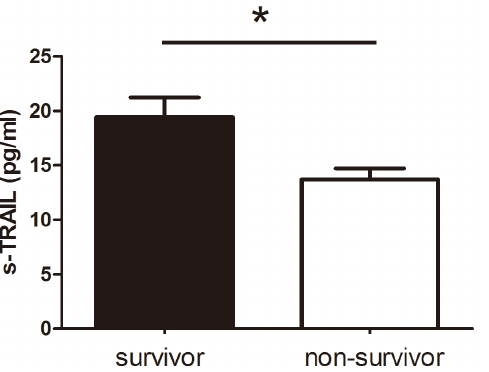
Figure 3. Plasma TRAIL levels in survivor and non-survivor groups. * compared with survivor group, P , 0.05.